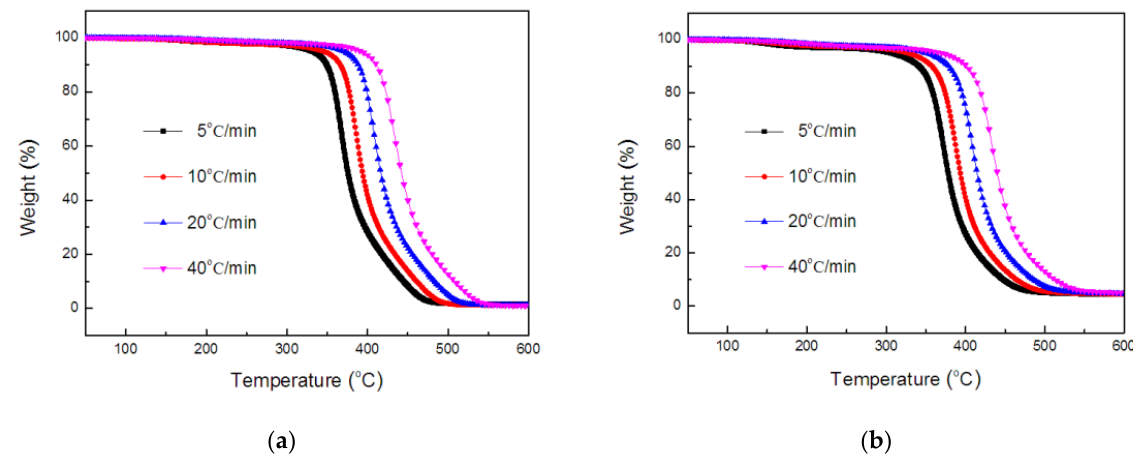
Figure 5. TGA curves of TE ( a ) and FRTE ( b ) composites.